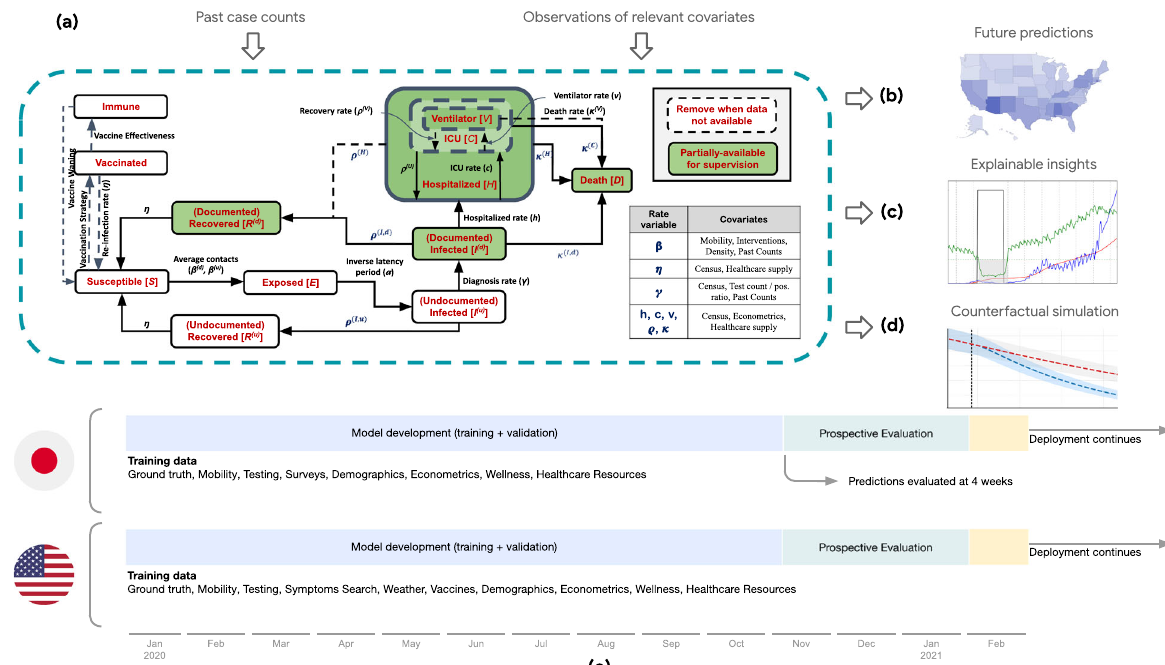
Fig. 1 Proposed framework and timeline for model development and prospective evaluation. a Our proposed AI-augmented epidemiology framework for COVID-19 forecasting is an extension to the standard Susceptible-Exposed-Infectious-Removed (SEIR) model 23,48 . We model compartments for undocumented cases explicitly as they can dominate COVID-19 spread, and introduce compartments for hospital resource usage as they are crucial to forecasts for COVID-19 healthcare planning. Learnable encoders infer the rates at which individuals move through different compartments, trained on static and time-varying public data, to model the changing disease dynamics over time and extract the predictive signals from relevant data. The models are trained daily on all available data up to the day each prediction is made (see “ Methods ” ). b Public dashboard that shows generated 28-day forecasts at county- and state level for the USA. A dashboard was similarly created in Japan at the prefecture level. c Predictions for the effective R number and force of infection that come from the compartmental nature of the model, as well as feature importances for the rates from the variable encoder architectures. d Simulations of counterfactual scenarios can be used to estimate the potential impact of vaccines or policy measures. e Prospective evaluation of the forecasts — on each prediction date, 28-day forecasts are released publicly, and the evaluation of the accuracy is performed at the end of the 28-day